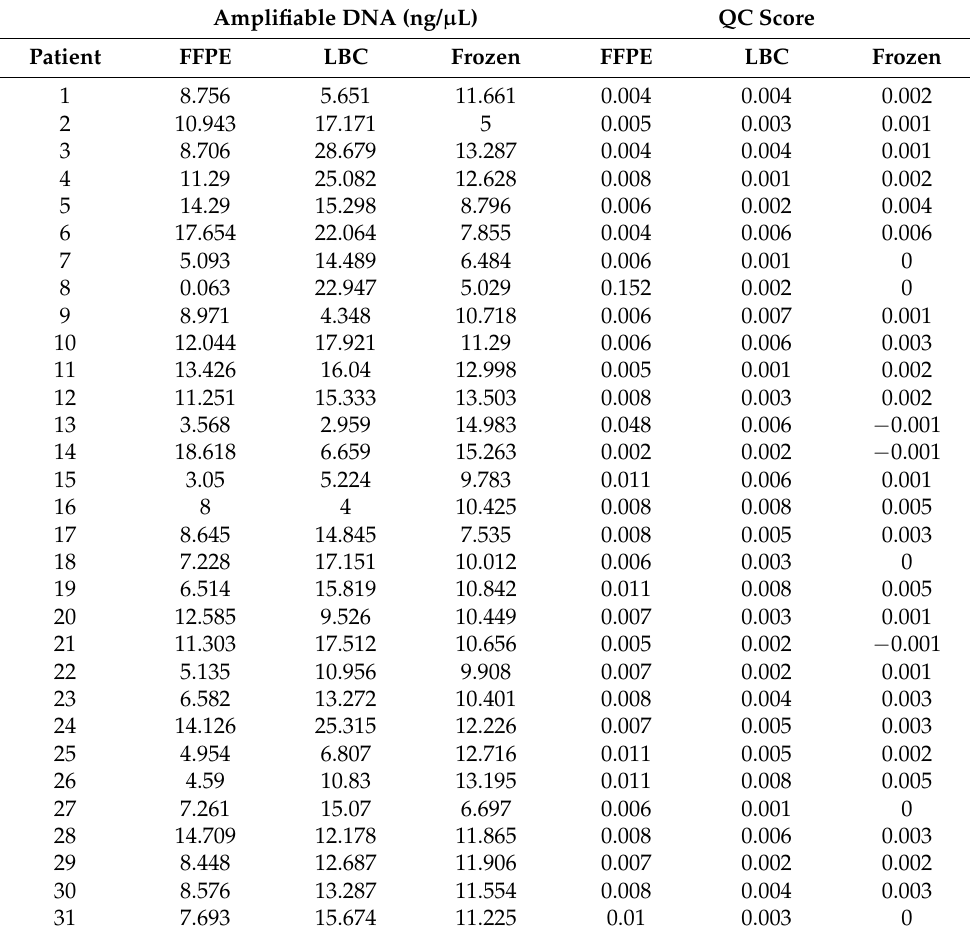
Table 2. Amplifiable DNA and quality check scores in all patients with